Question: Describe this figure in one sentence.
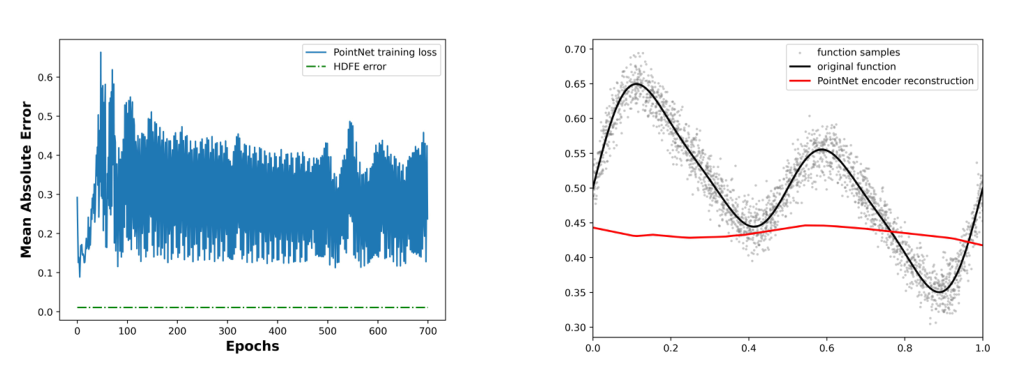
Answer: PointNet fails to learn an effective function encoder. Left: Training curve of the PointNet function encoder. The error is still significantly higher than HDFE though training for 700 epochs. Right: The PointNet function encoder does not produce a reasonable reconstruction.